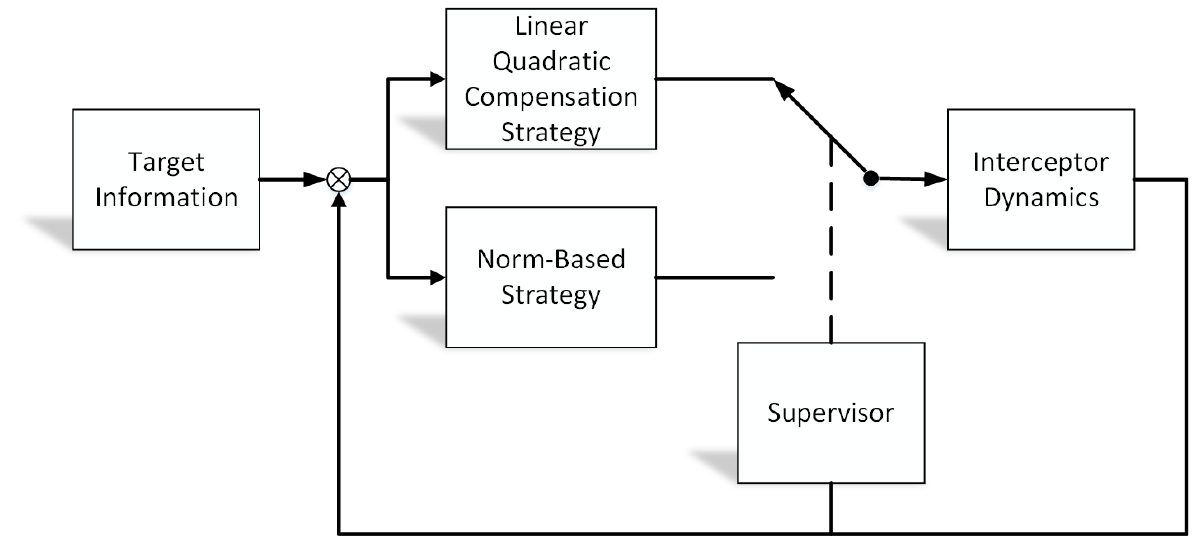
Figure 2. Closed-loop system hybrid strategy scheme.